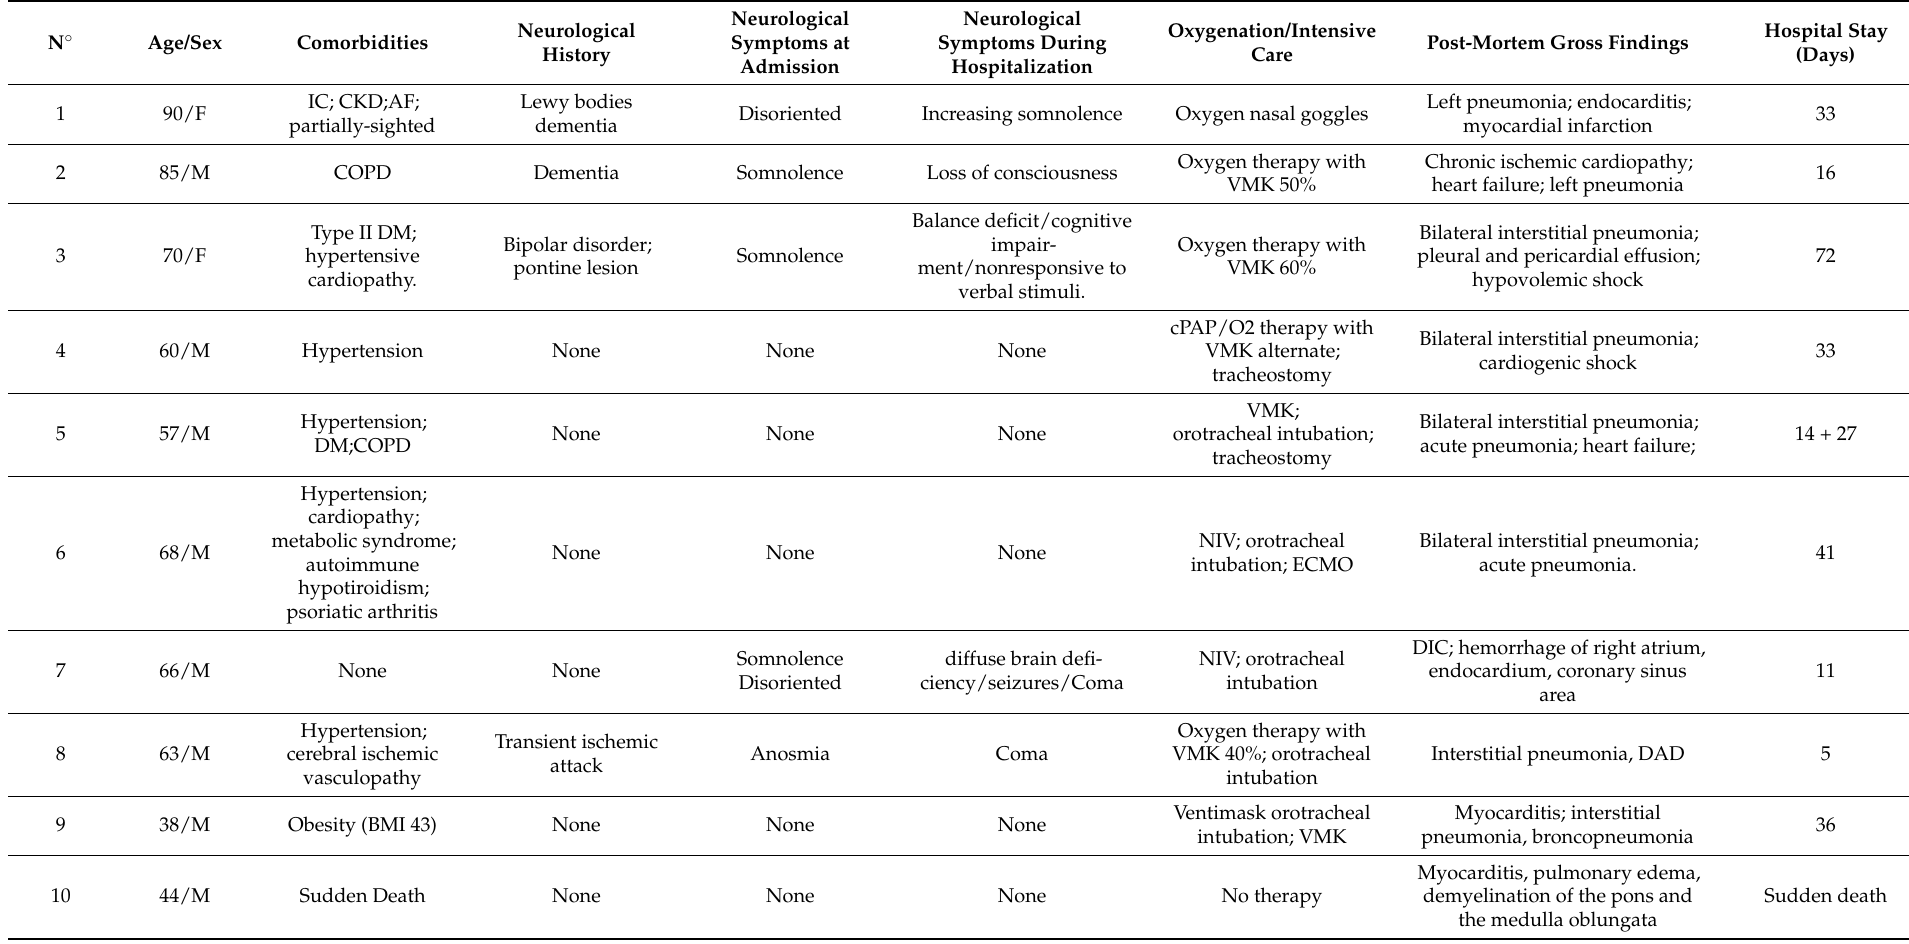
Table 1. Demographic, neurological history and clinical